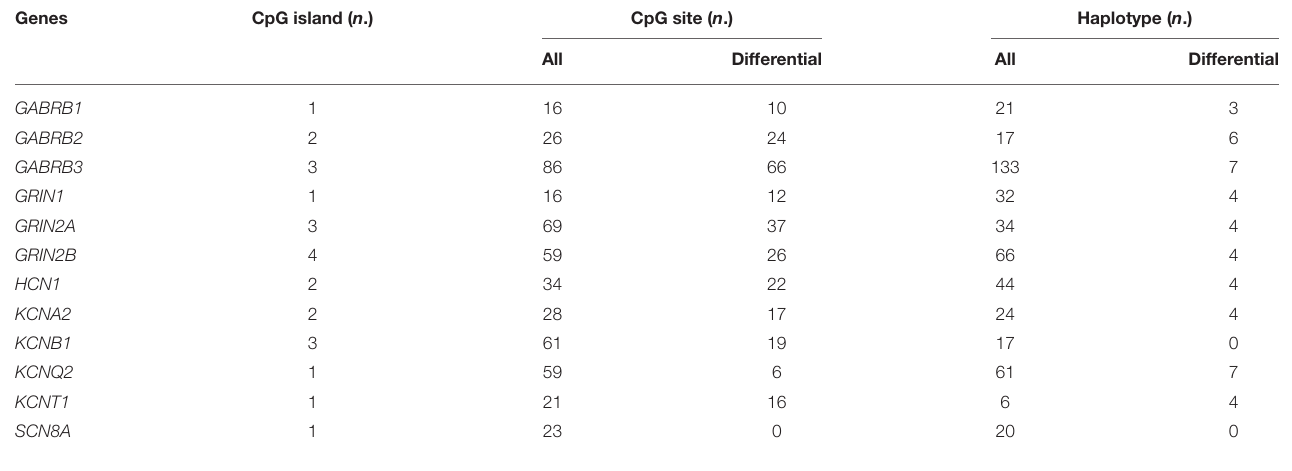
TABLE 3 | Methylation details of 12 ion-channel genes between TLE cases and controls.